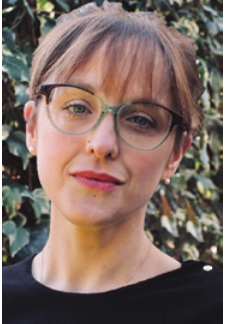
Figure 4 Katie Hemer (Source: photograph by Victor